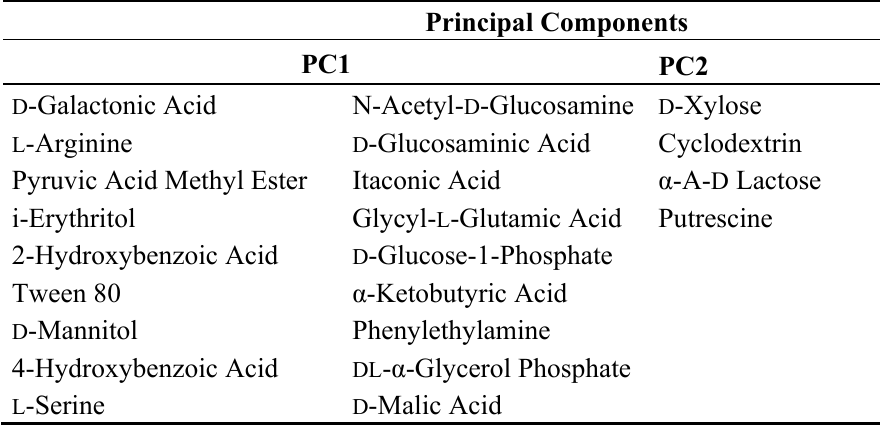
Table 3. Carbon substrates utilized by the microorganisms in Biolog EcoPlate TM that were significantly correlated to PC1 and PC2 (R > 0.70).